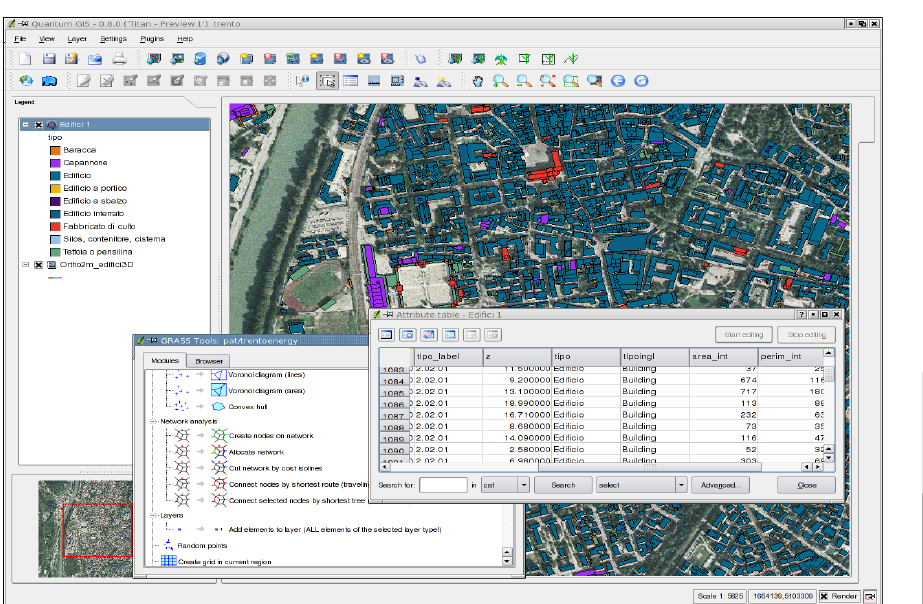
Figure 6 – Kvantum GIS 0.8.0